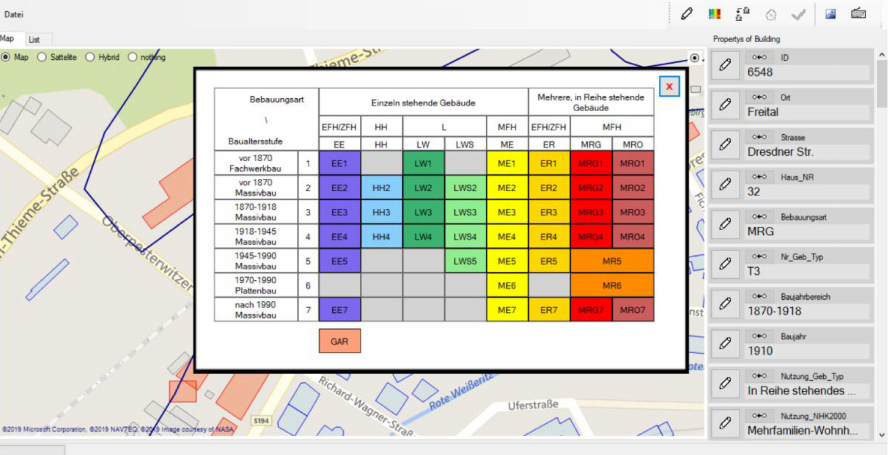
Figure 3. Selection field for the building typology in the improved survey tool EQUIP.